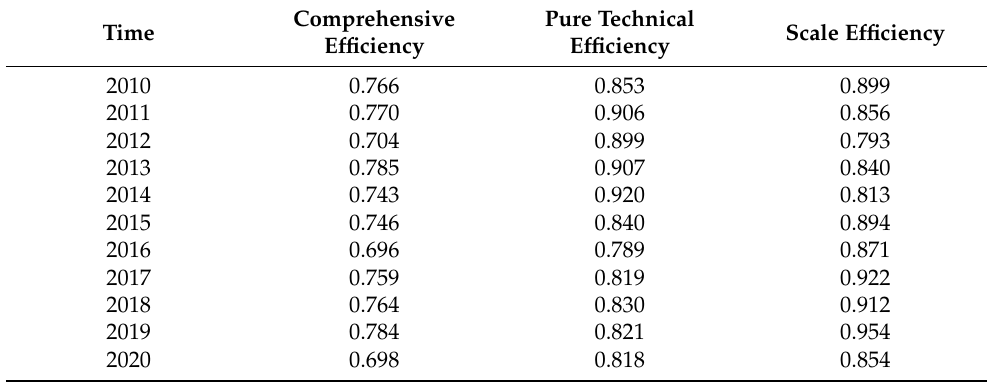
Table 3. DEA estimation results of the first stage: average of the whole province. Comprehensive Pure Technical Time Scale Efficiency Efficiency Efficiency 2010